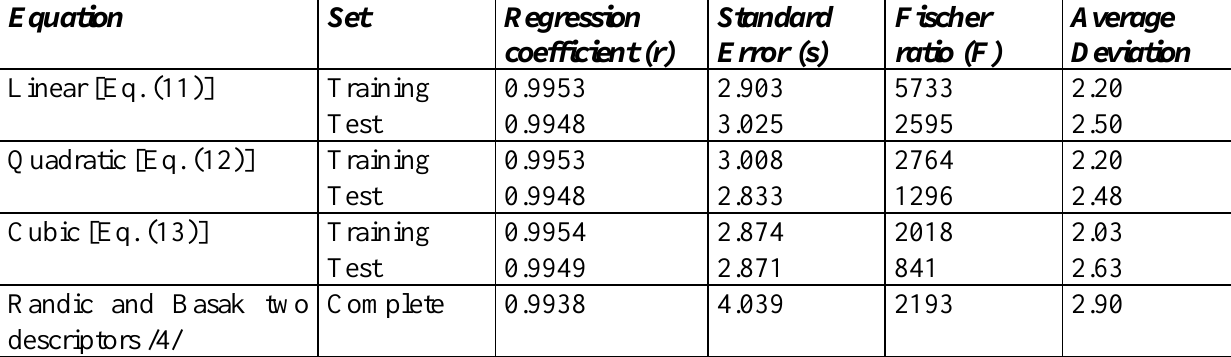
Table 2. Statistical parameters corresponding to the regression